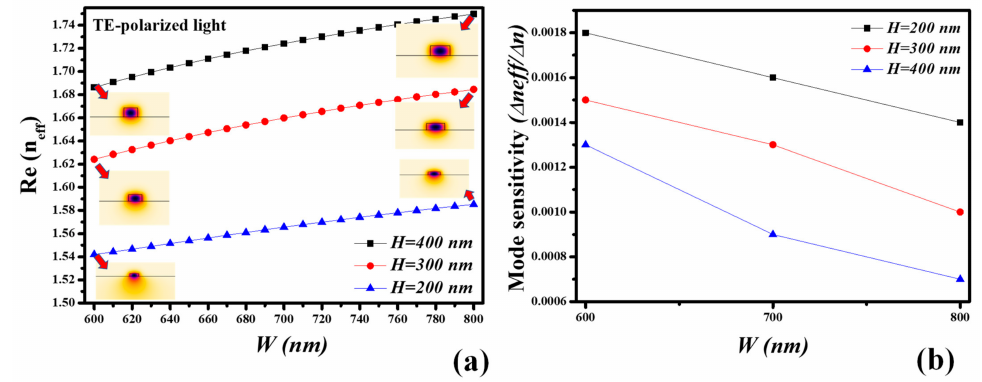
Figure 12. Modal characteristics, ( a ) real part of n eff of SiO 2 -TiO 2 ridge waveguide for TE-polarized light at operation wavelength of 980 nm, ( b ) mode sensitivity